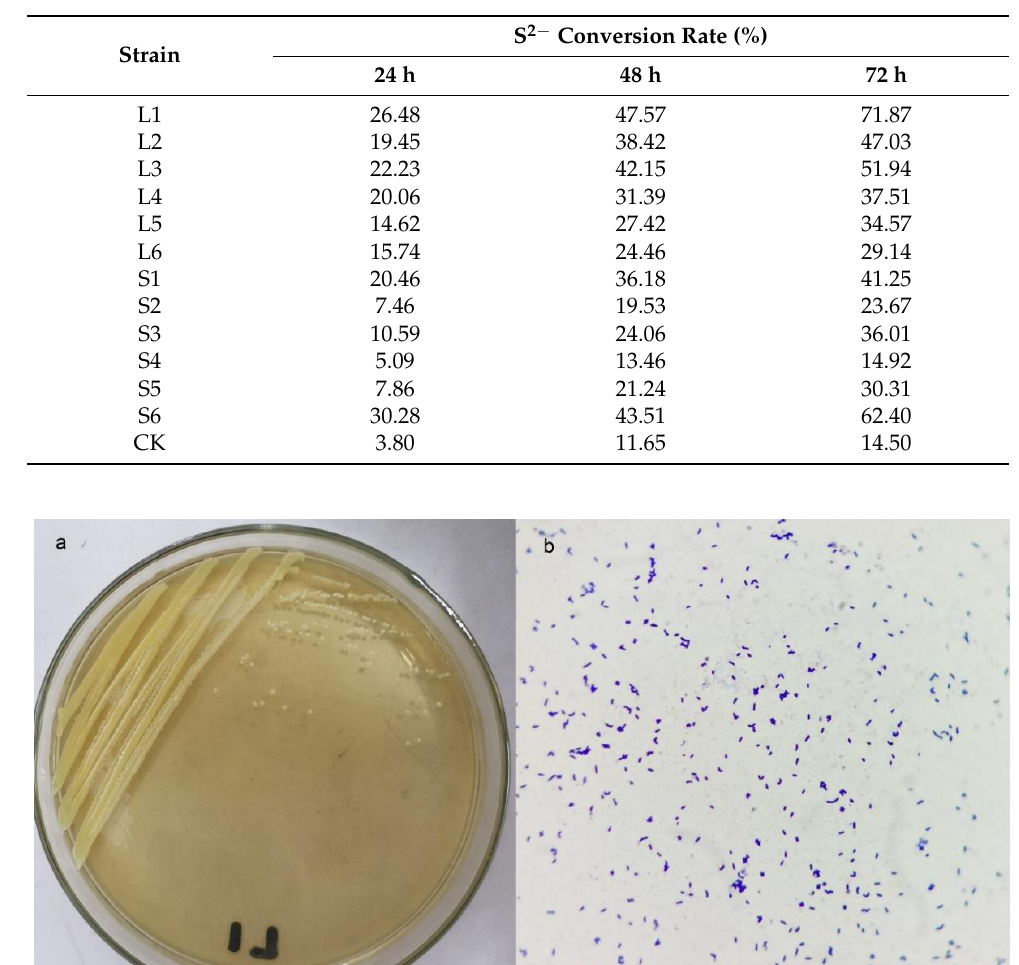
Table 1. S 2 − conversion rate of different strains isolated from wastewater.